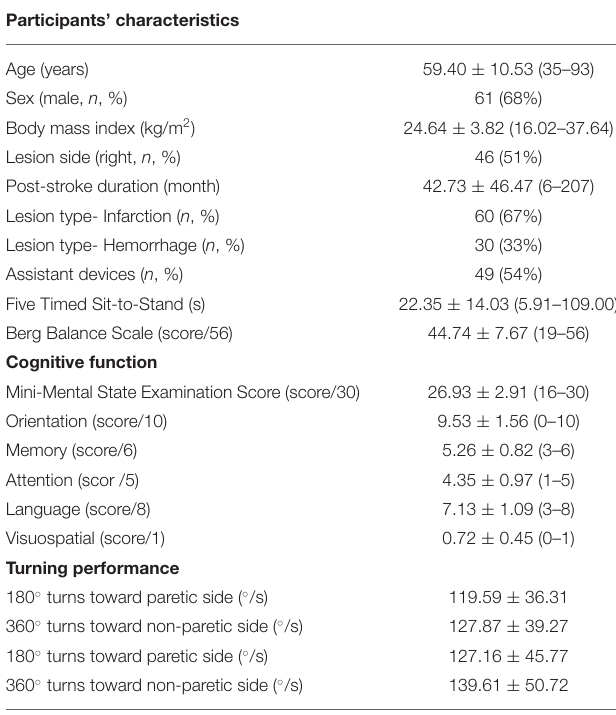
TABLE 1 | Demographic characteristics, cognitive function and turning performance of patients with stroke ( N =